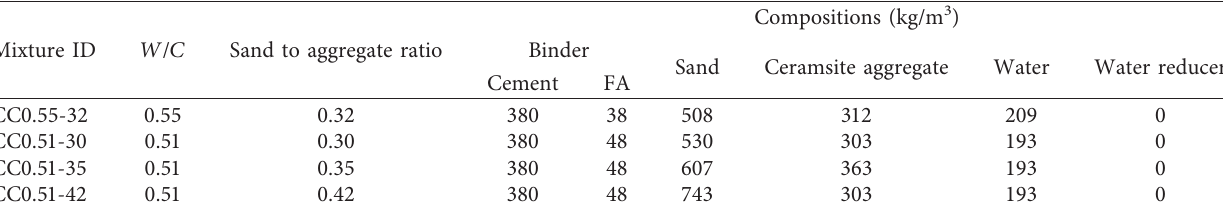
Table 4: Mixture proportions of ceramsite concrete.